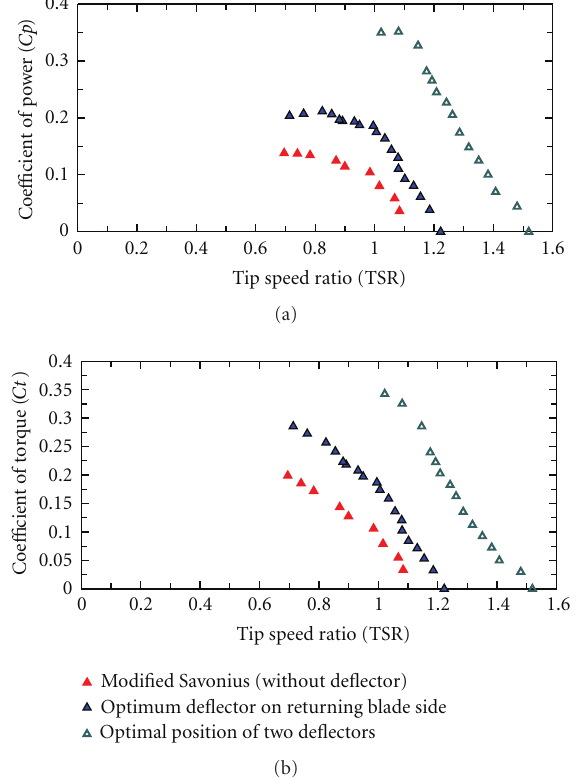
Figure 13: Comparison of coe ffi cient of power and coe ffi cient of torque with TSR for modified Savonius rotor with and without single and two deflector